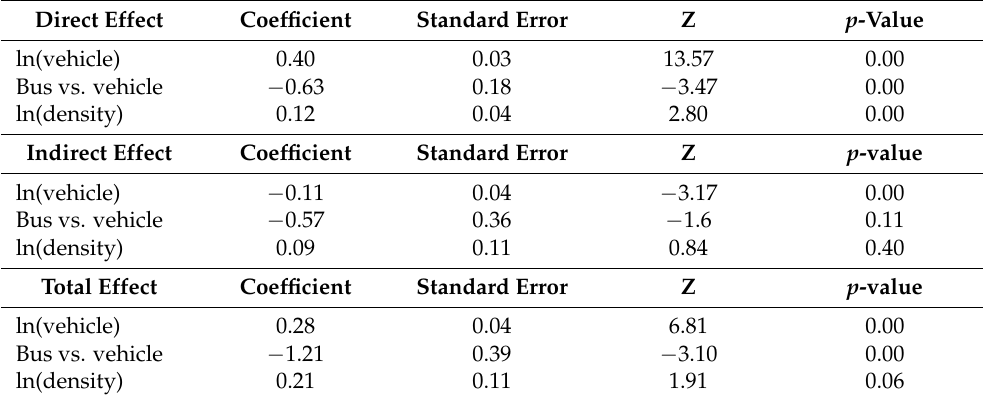
Table 8. Spatial spillover